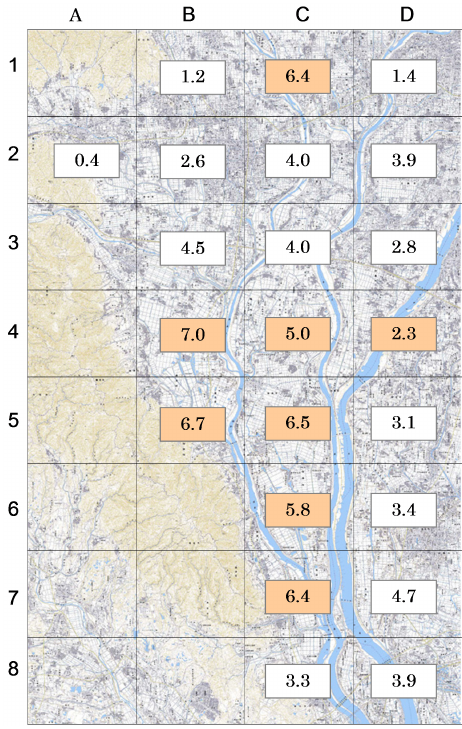
Figure 7. Average Cumulative value of land subsidence (1989–